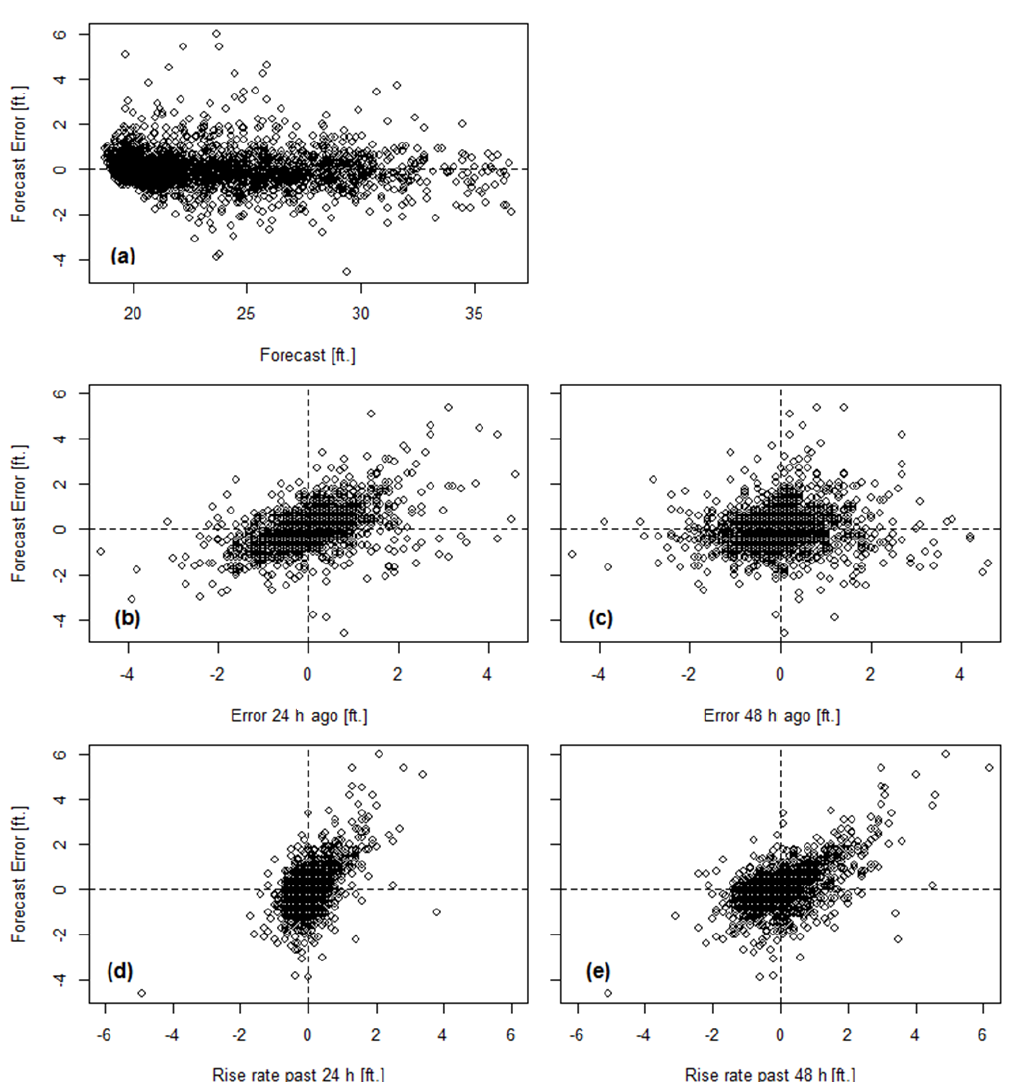
Figure 11. Independent variables plotted against the forecast error for Hardin, IL, with 3 days of lead time. First row: forecast; second row: past forecast errors; third row: rates of